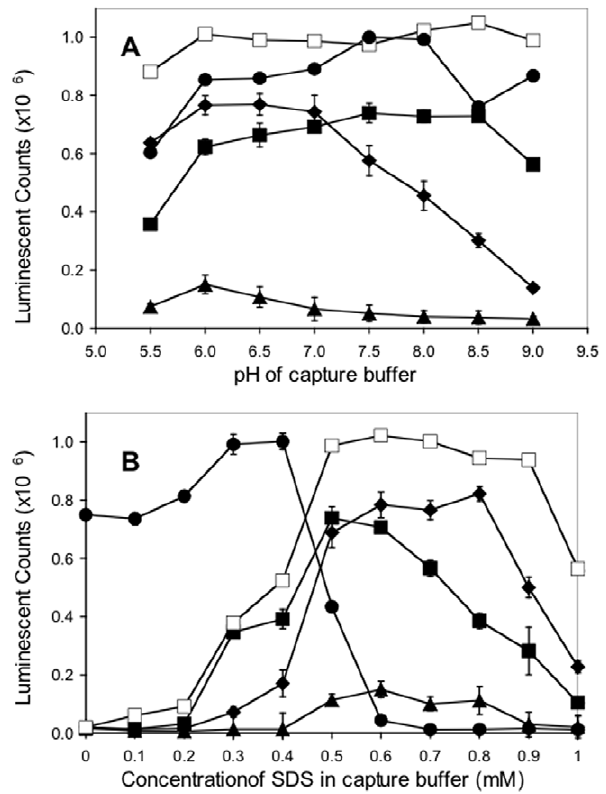
Figure 4. Effects of SDS concentration and pH on BoNT/B N capture. Plates were coated with the capture antibody: F24-1 X ; F26- . A . pH of capture buffer (1 6 TBS) 16 & ; F27-33 m ; F29-40 % ; MCS6-27 was adjusted for each capture antibody at concentrations of SDS as follows; F24-1, 0.7 mM; F26-16, 0.5 mM; F27-33, 0.6 mM; F29-40, 0.6 mM; MCS6-27, 0.3 mM. B . Concentration of SDS in capture buffer was adjusted for each capture antibody at the following pH; F24-1, pH 6.0; F26-16, pH 7.5; F27-33, pH 6.0; F29-40, pH 8.0; MCS6-27, pH 8.0. Data are presented as average of 3 samples 6 1 standard error.